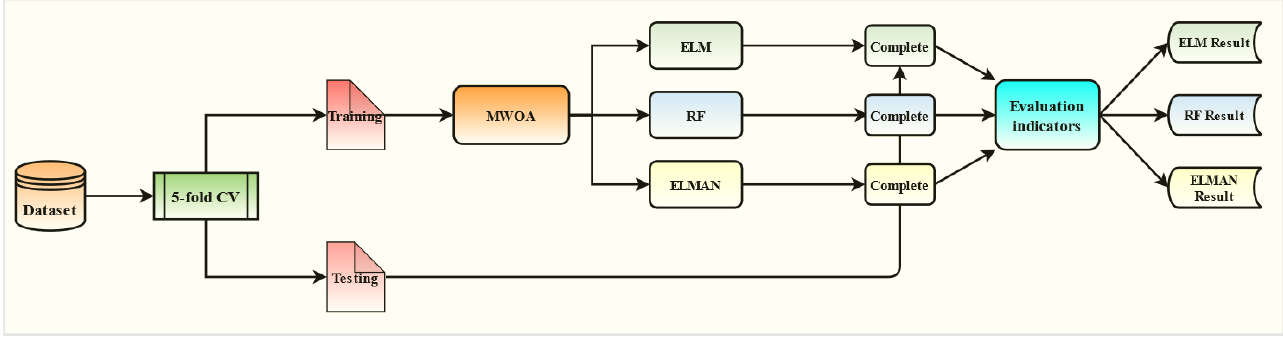
Figure 7. Flow chart of the research process.